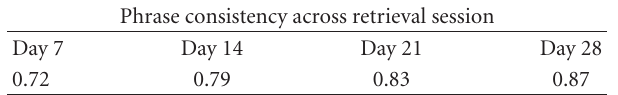
Table 1: Mean phrase consistency across multiple retrieval sessions. For each retrieval session of the multiple retrieval condition follow- ing Day 1, the number of details repeated from the previous re- trieval session was divided by the total details from the previous retrieval session.